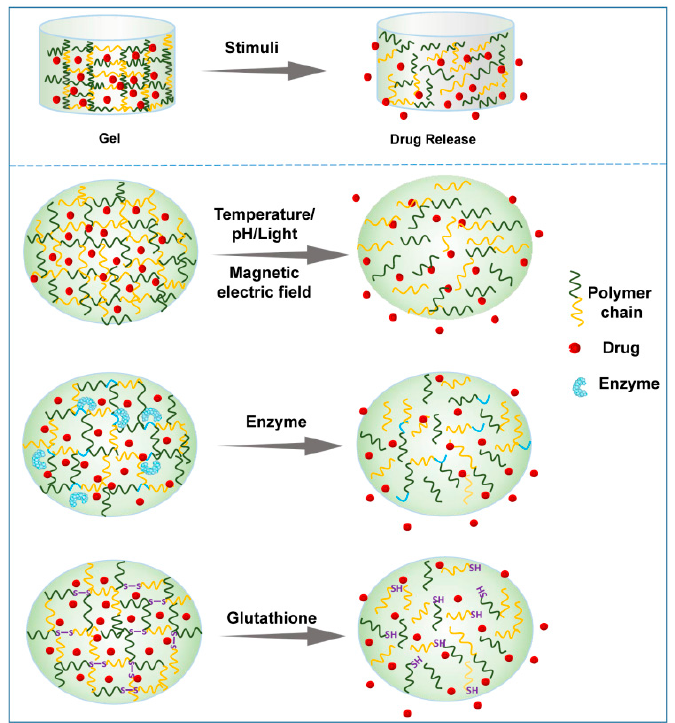
Figure 4. Schematic presentation of drug release from representative smart hydrogels upon various stimuli.